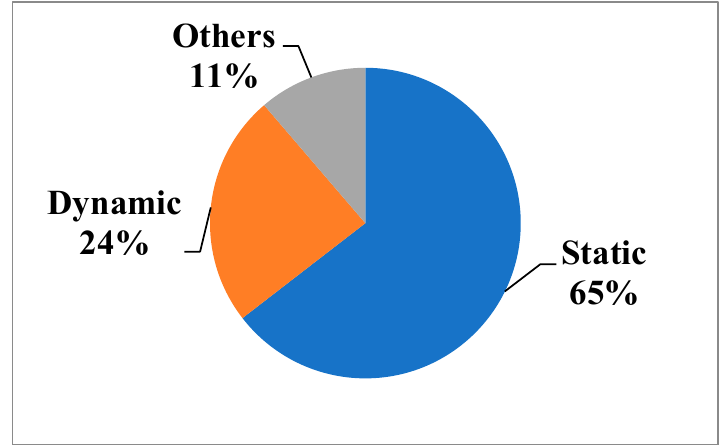
Figure 4. Percentage distribution of different models.